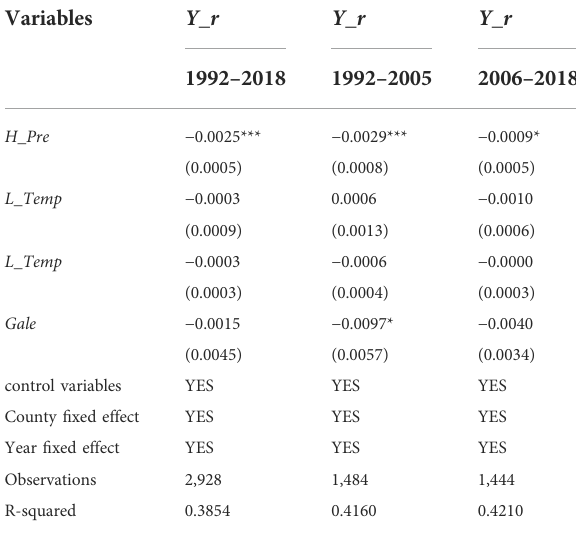
TABLE5ThePUY ofricechangescorresponding withthehigh-impact weather (1992 – 2005 vs. 2006 – 2018).